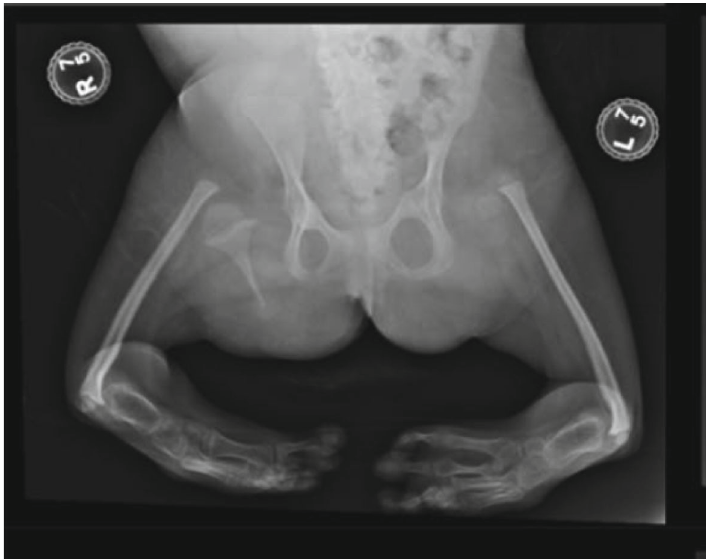
Figure 1: Anteroposterior X-ray showing shortening of bilateral lower extremities with dysplasia of the right femur and bilateral acetabula. The left femur and bilateral fi bula are not seen. Partial visualization of the bilateral tibia and the right talus is